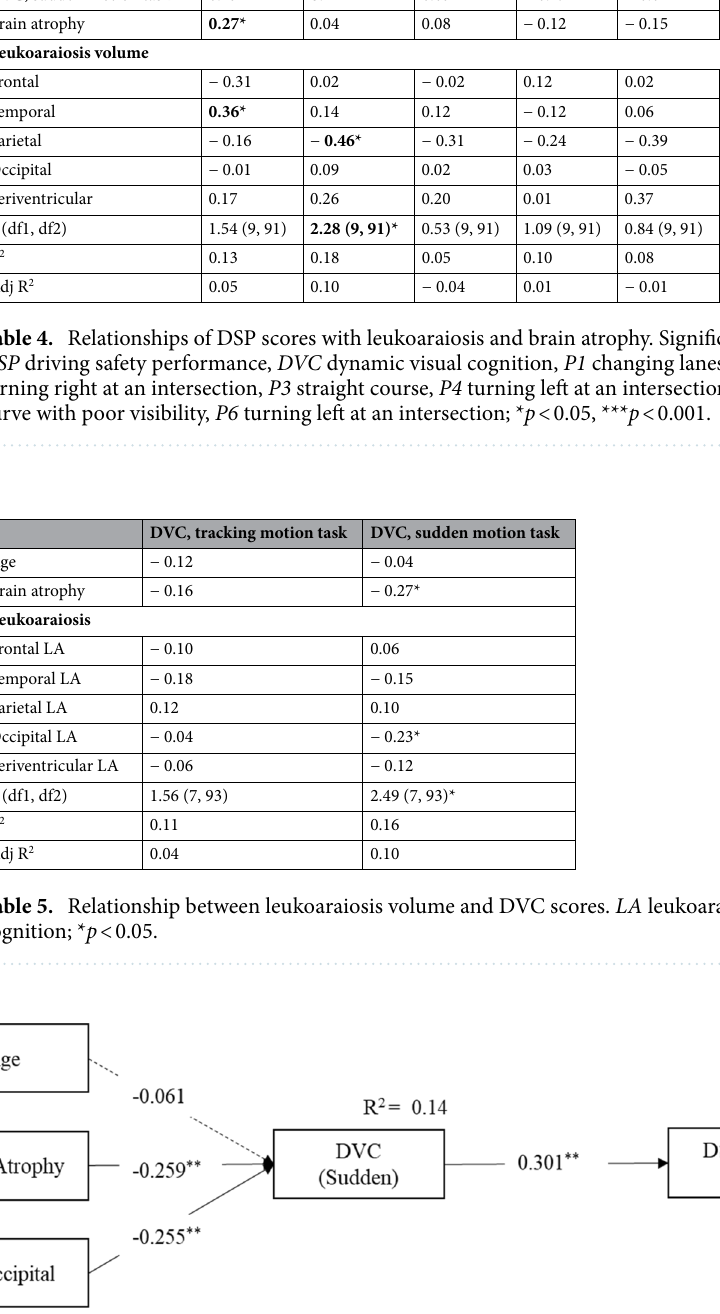
Figure 3. Final model. The dotted arrow indicates a non-significant path. Chi-squared (df = 3) = 1.9, p = 0.602, GFI = 0.993, AGFI = 0.964, RMSEA = 0.000, AIC = 1411.3. DSP driving safety performance, DVC dynamic visual cognition, LA leukoaraiosis, GFI goodness of fit index, AGFI adjusted goodness of fit index, RMSEA root mean square error of approximation, AIC Akaike’s information